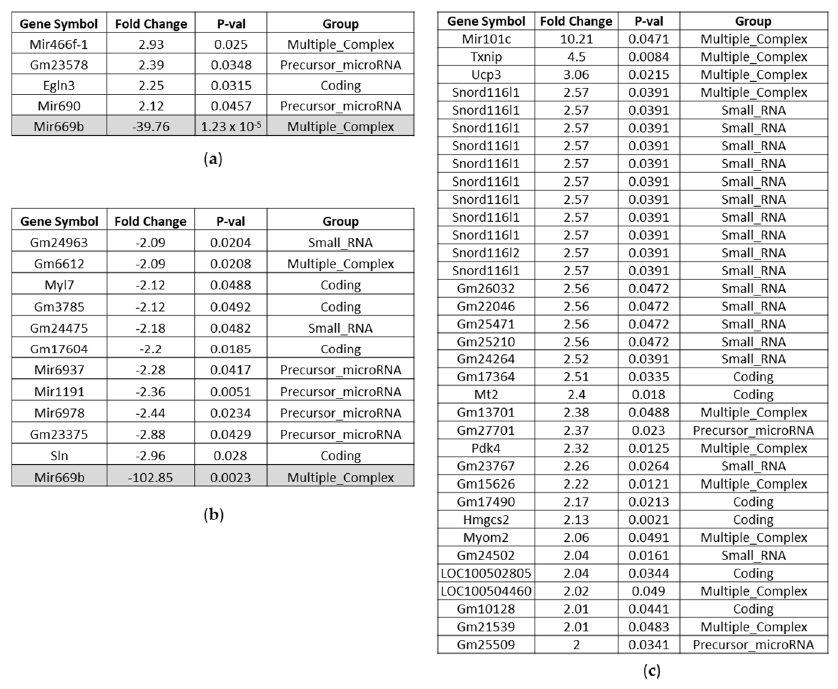
Figure 6. Affected genes in the heart of BC- vs. control-fed mice. ( a ) Significantly up-regulated and down-regulated genes (highlighted in grey) after 2 days BC-fed mice compared to control-fed mice (up-regulated > 2.0; down-regulated < − 2.0). ( b ) Significantly down-regulated genes after 8 days BC- fed mice compared to control-fed mice (down-regulated < − 2.0). ( c ) Significantly up-regulated genes after 8 days BC-fed mice compared to control-fed mice (up-regulated > 2.0). Noncoding RNAs and pseudogenes are not included.